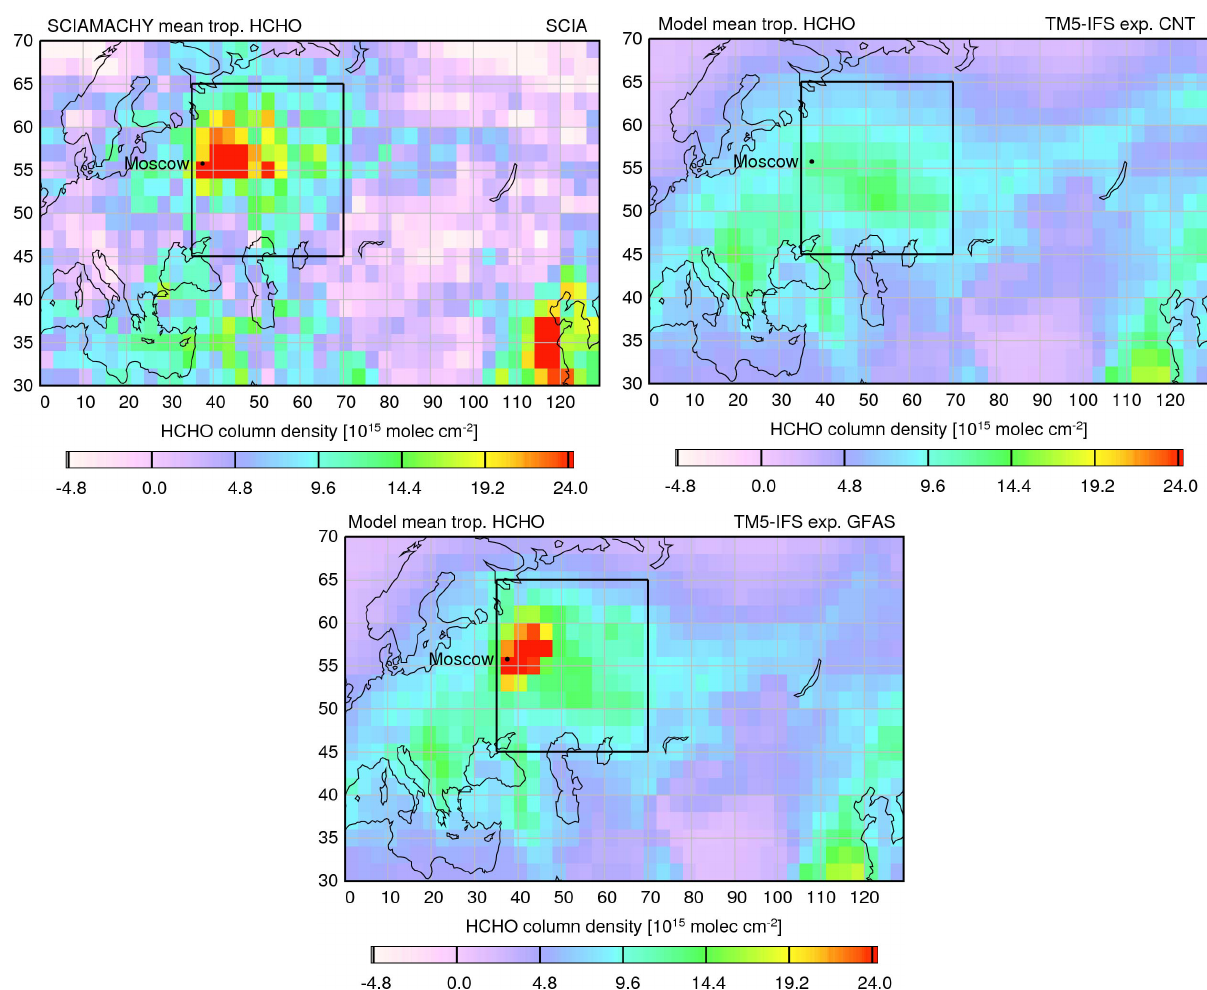
Fig. 15. Maps of mean tropospheric HCHO columns as observed from SCIAMACHY between 20 July and 15 August compared to the D+0 columns from the runs CNT and GFAS.